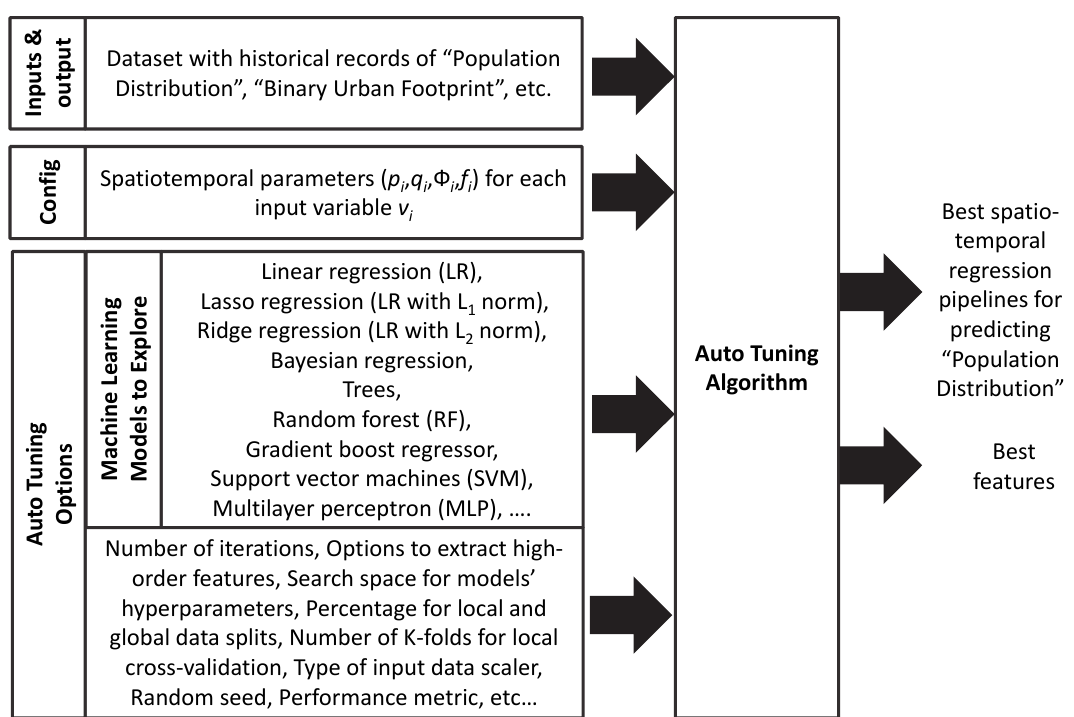
Figure 9. Automated training, validation, and testing of the regression model to estimate the population